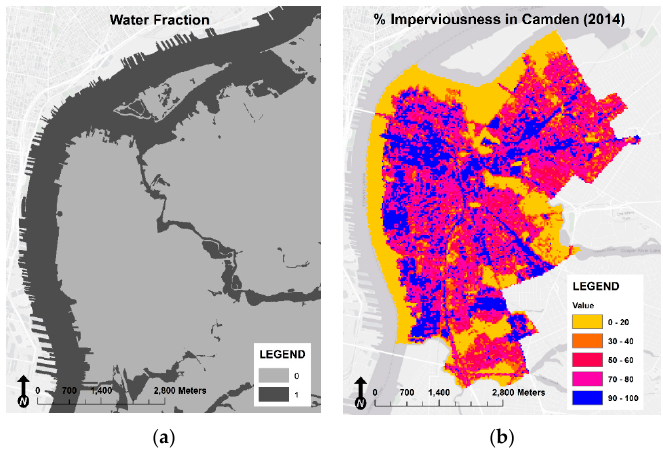
Figure 4. Environmental parameters mapped over Camden city: ( a ) water fraction (1 = water pixels, 0 = non-water pixels); ( b ) percent impervious area (%).